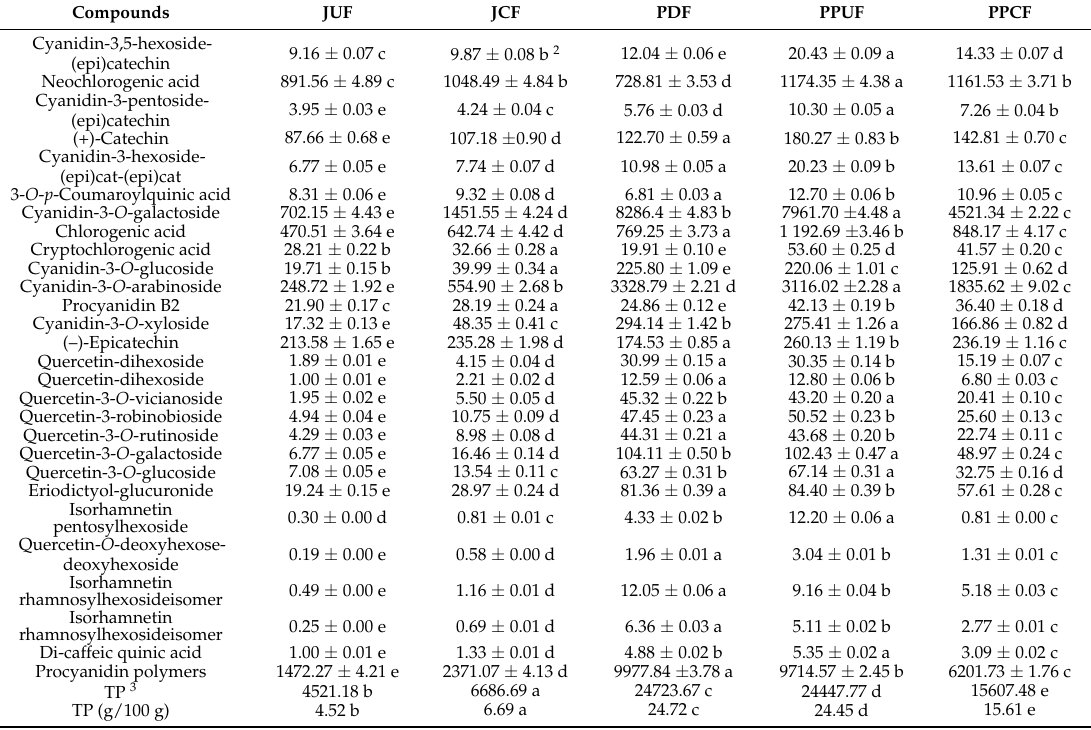
Figure 1. Polyphenol group content in the black chokeberry products (mg/100 g dm). Abbreviations: JCF, juice of crushed fruits before pressing; JUF, juice of uncrushed fruits before pressing; PPUF, dry powder from pomace of uncrushed fruits; PPCF, dry powder from pomace of crushed fruits; PDF, dry powder of whole fruits. Table 3. Polyphenol contents in black chokeberry products (mg/100 g dm) 1 .